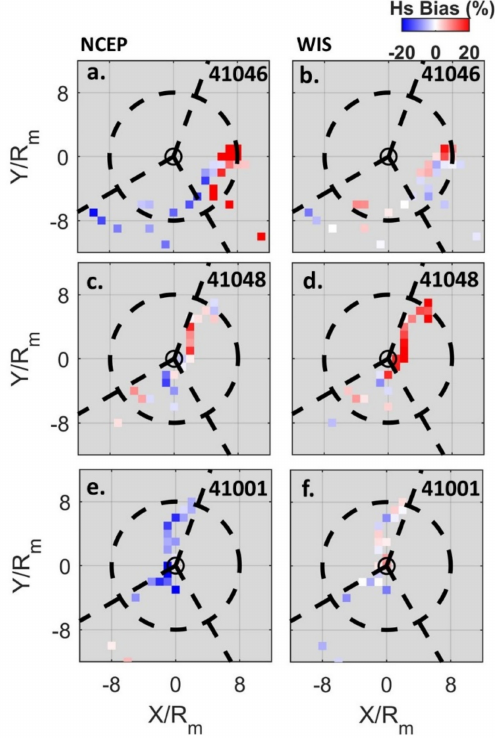
Figure 10. ( a , c , e ) NCEP and ( b , d , f ) WIS Hs biases at buoys ( a , b ) 41046, ( c , d ) 41048, ( e , f ) 41001 during Hurricane Sandy. Plots are in a storm-centric frame of reference with distance from the eye normalized by the radius of maximum winds (Rm). Observations were binned into 1 Rm × 1 Rm bins. The inner circle denotes 1 Rm and outer dotted circle denotes 8 Rm. Direction of storm motion is up the